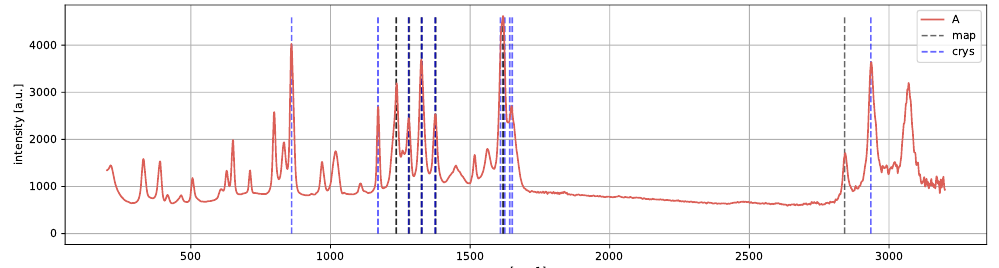
Figure 12. Spectrum C , assigned to solution phase paracetamol.